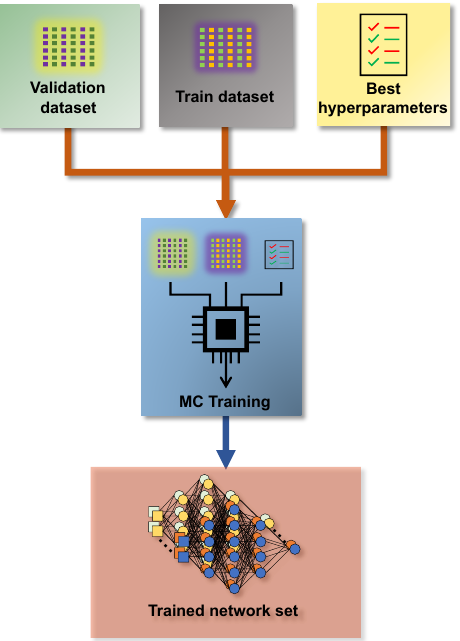
Figure 5. Monte Carlo training